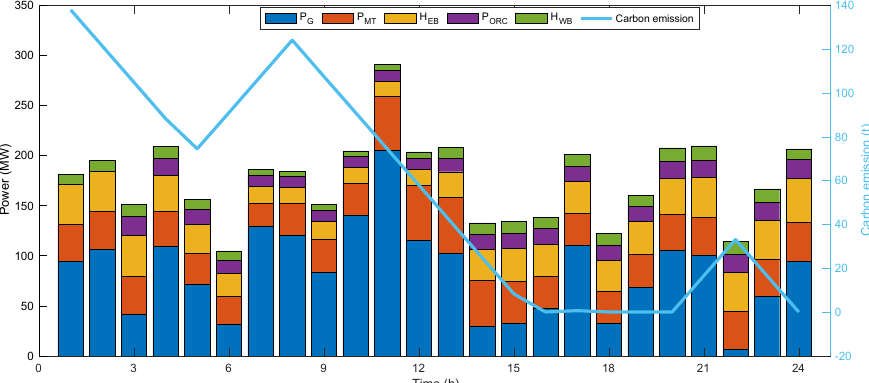
Figure 9. Power dispatch of the MEVPP system under Scenario 3.